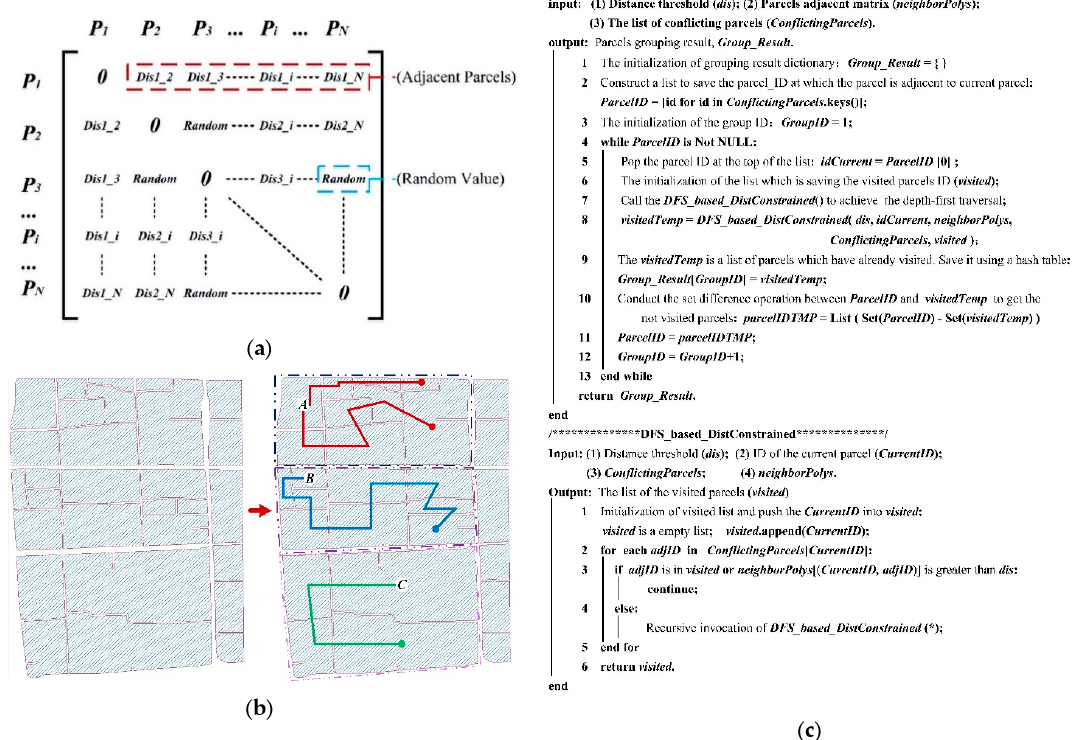
Figure 7. Urban parcel grouping method: ( a ) Construction process of the parcels adjacent matrix; ( b ) diagrammatic sketch of parcel grouping trees; and ( c ) description of parcel grouping algorithm.